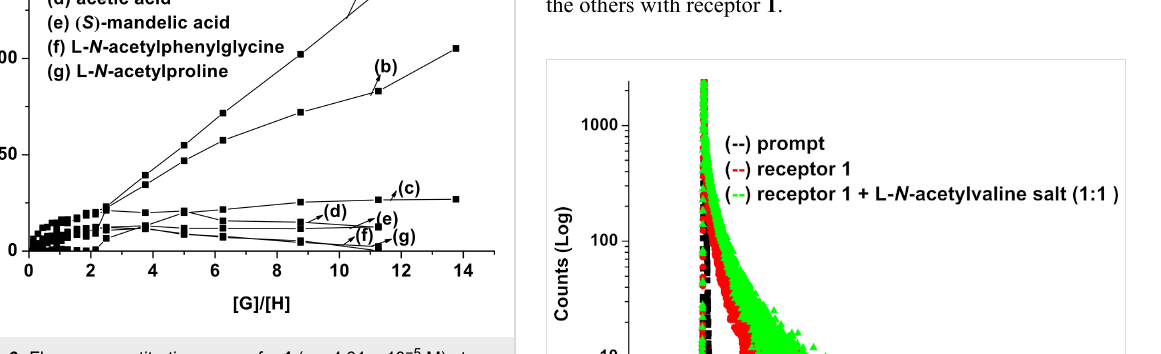
Figure 6: Fluorescence titration curves for 1 ( c = 4.31 × 10 − 5 M) at 492 nm.